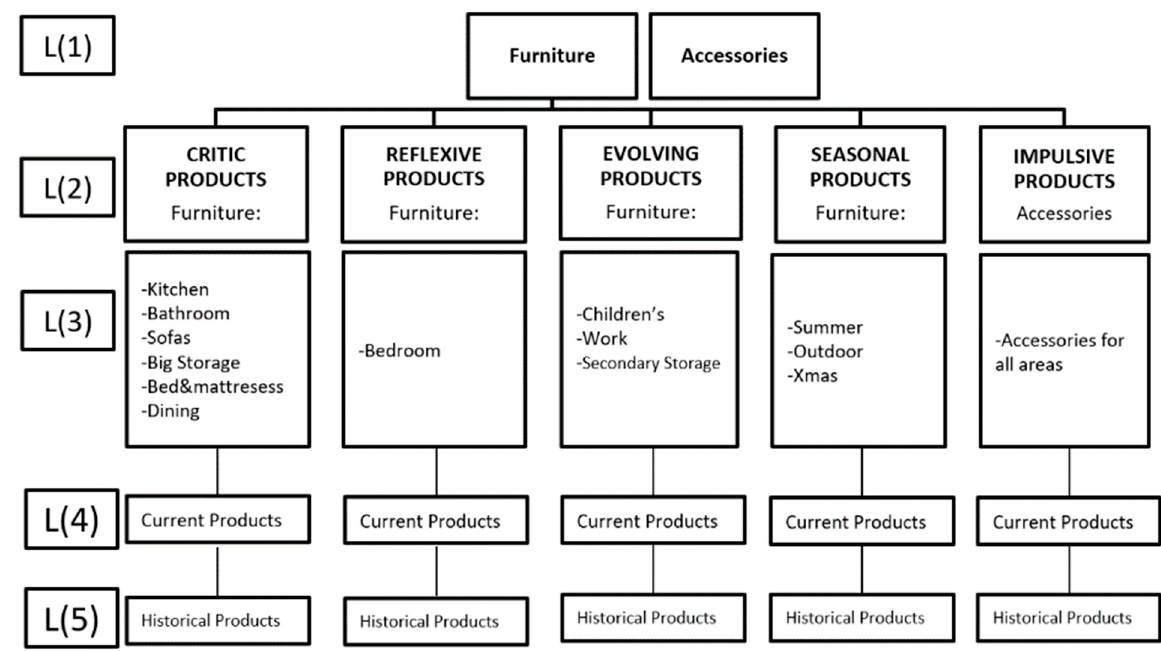
Figure 7. New product hierarchy H.